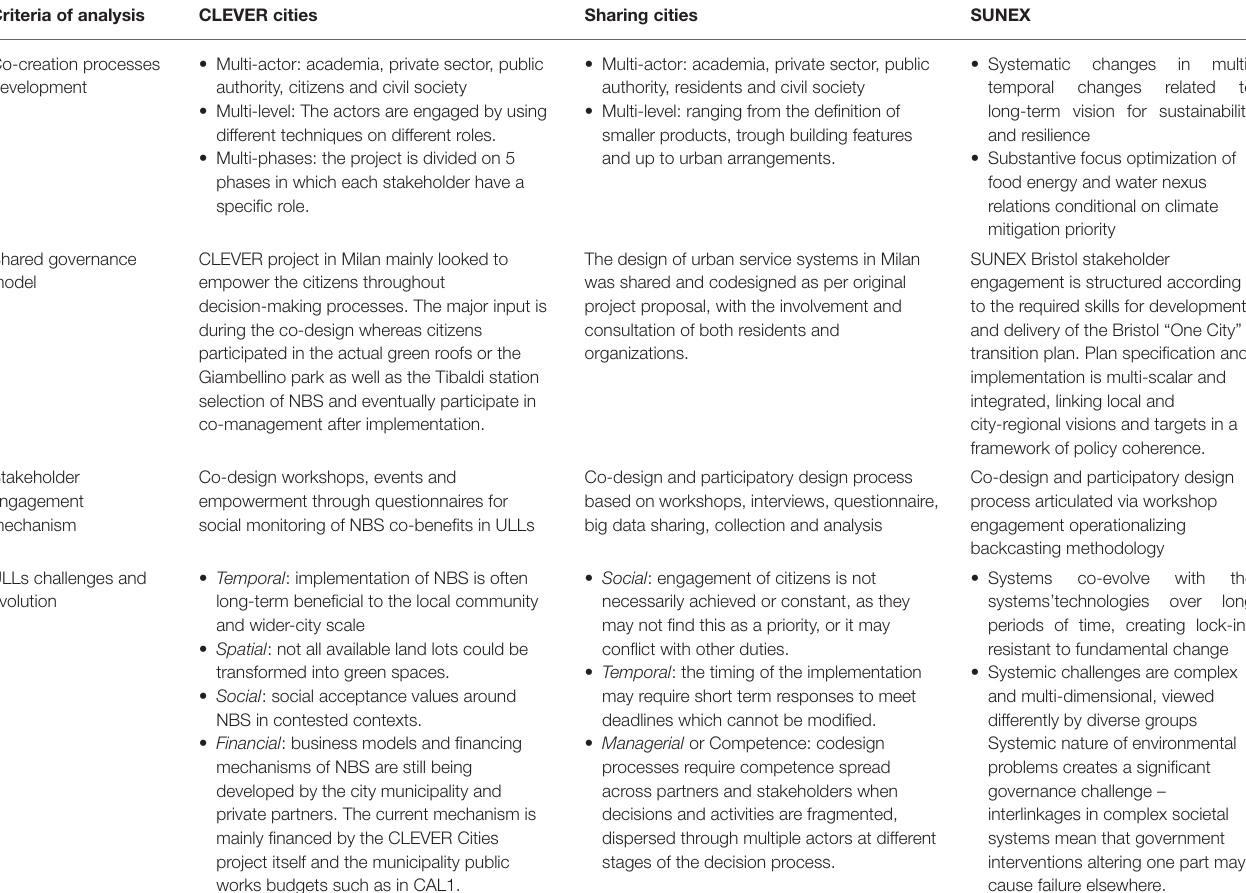
TABLE 5 | Resulting cross-comparative analysis from the three main research